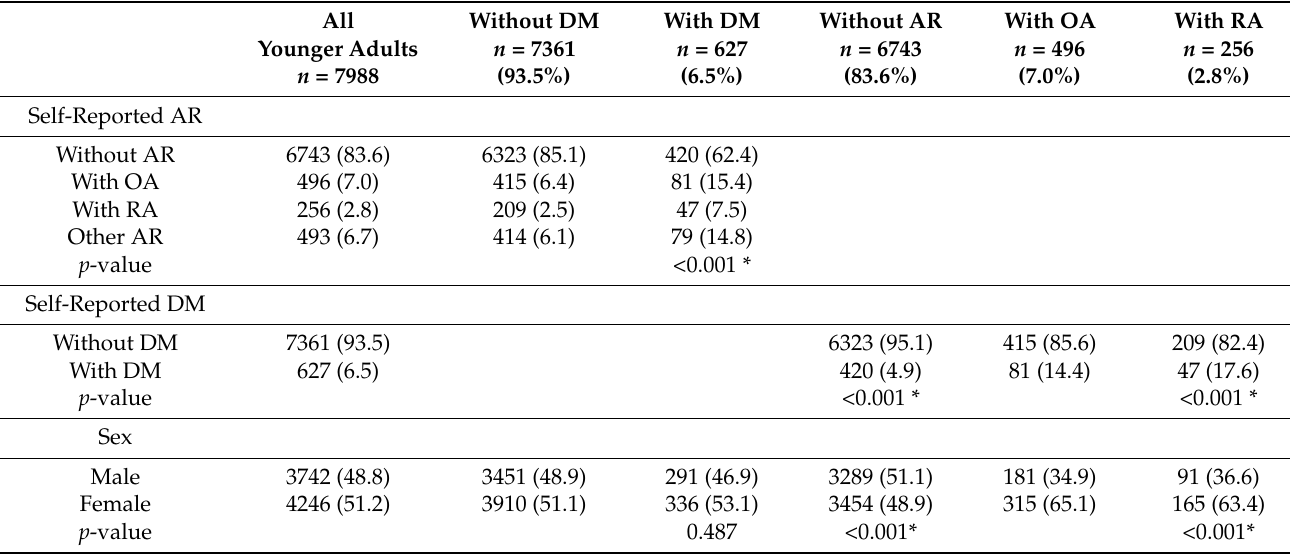
Table 1. Sociodemographic characteristics of younger US adults by self-reported diabetes mellitus status and arthritis status: National Health and Nutrition Examination Survey (NHANES)